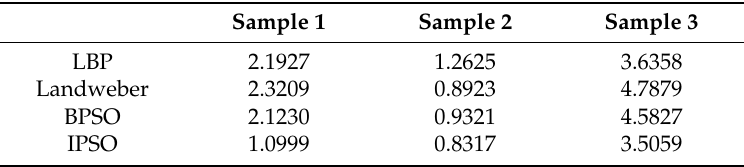
Table 2. Relative image error I e by different